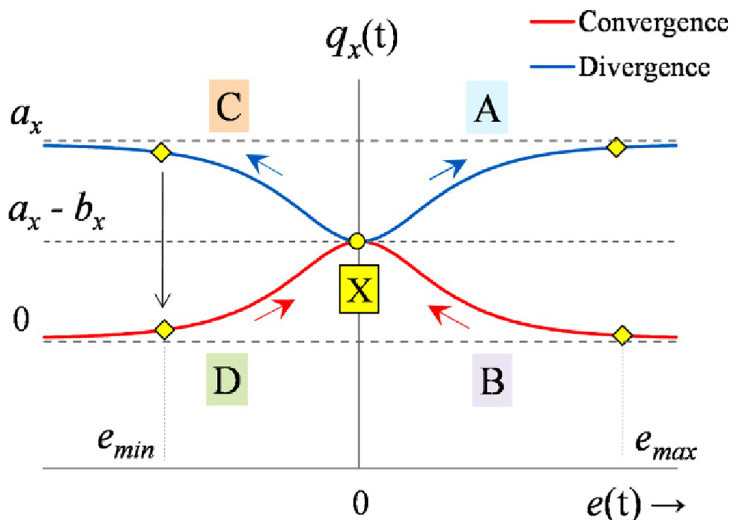
Fig 9. Variation rules for weighting coefficients in every